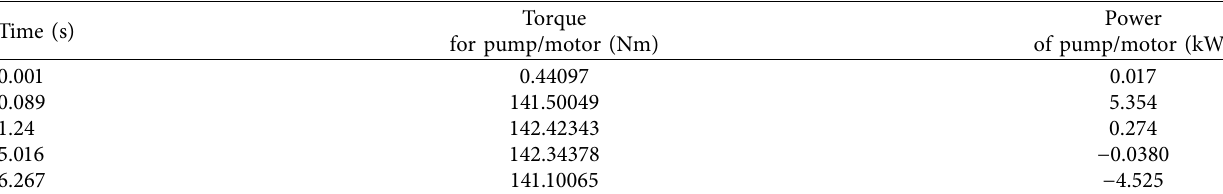
Table 8: Variations in starting torque, pump/motor braking, and power.